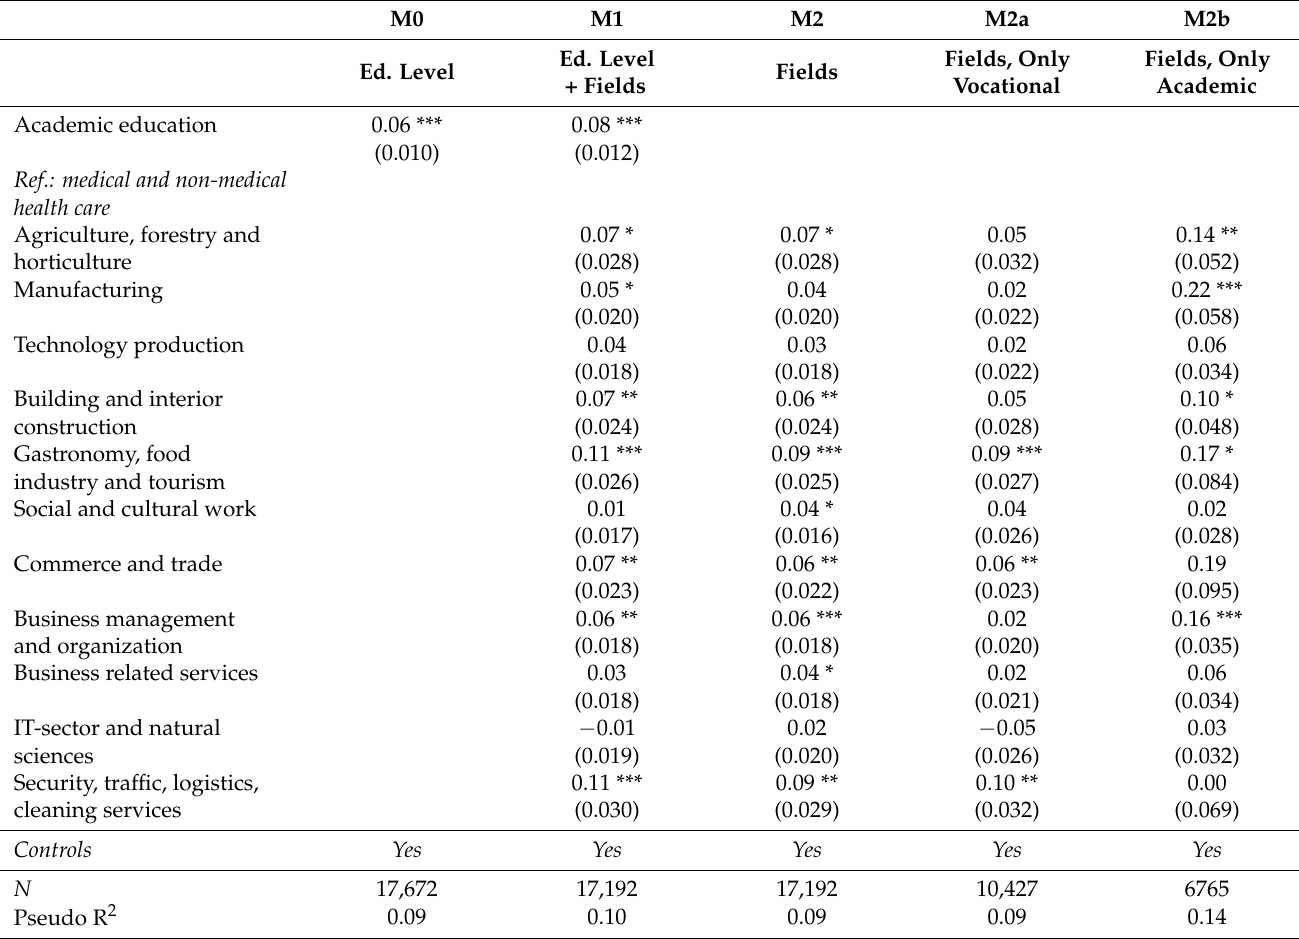
Table 2. Logit regression models of overeducation (subjective indicator) on educational level and educational fields (AME) 1 . M0 M1 M2 M2a Ed. Level + Fields